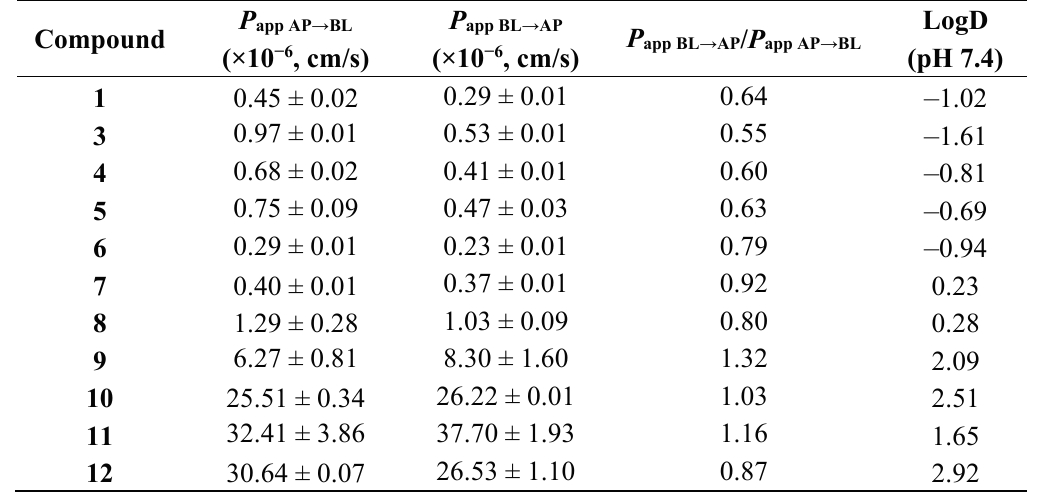
Table 1. Bidirectional P app values of the eleven compounds of TMF in the Caco-2 model.